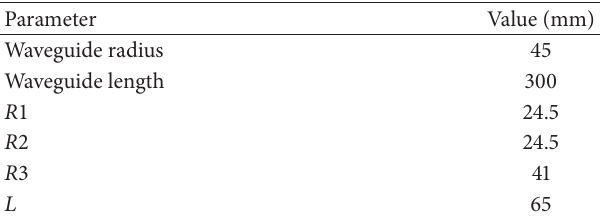
Table 1: Parameters of the proposed Vlasov